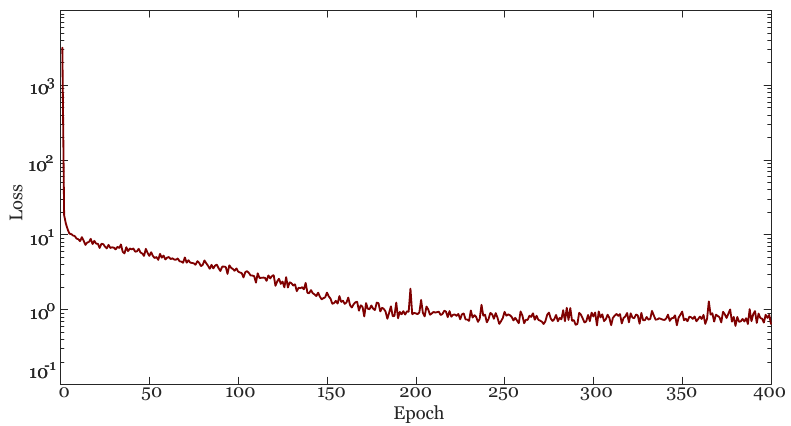
Figure 6. Loss curve for LSTM